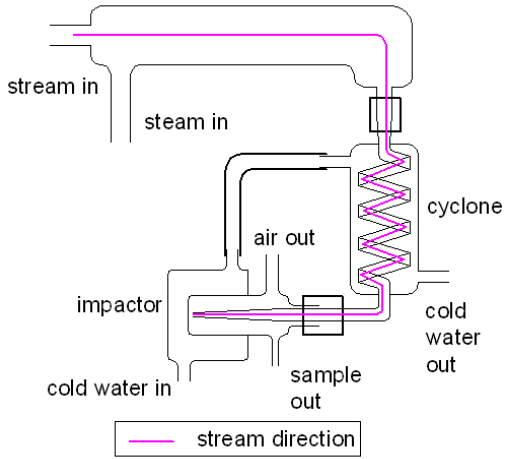
Fig. 1. The newly designed aerosol collector used in the GAC to enhance the aerosol collection efficiency.